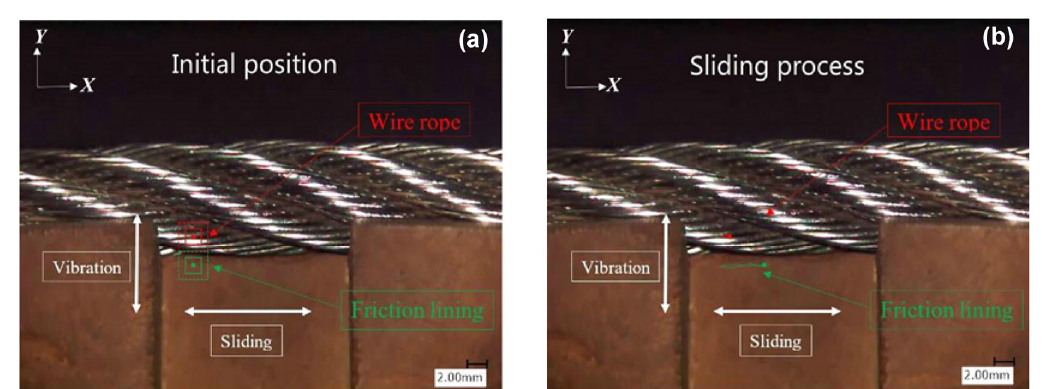
Fig. 3 Tracking the displacement of the marked points: (a) Initial position and (b) sliding